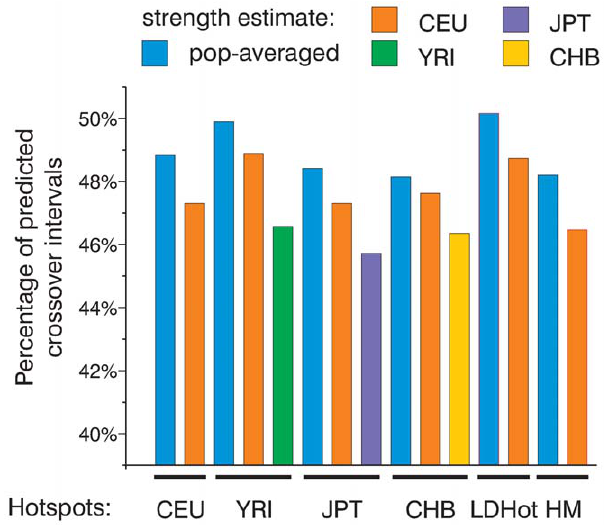
Figure 4. All sets of hotspots are similarly efficient in predicting crossovers. We calculated and plotted the fraction of crossover intervals smaller than 50 Kb overlapping 10,000 strongest hotspots defined in several ways. We have used LDHot hotspots (LDHot) and peak-based hotspots from the population-averaged map (HM) and four population specific maps (CEU, YRI, JPT, and CHB). For ranking, we have used either four population-specific or population- averaged strength estimates.